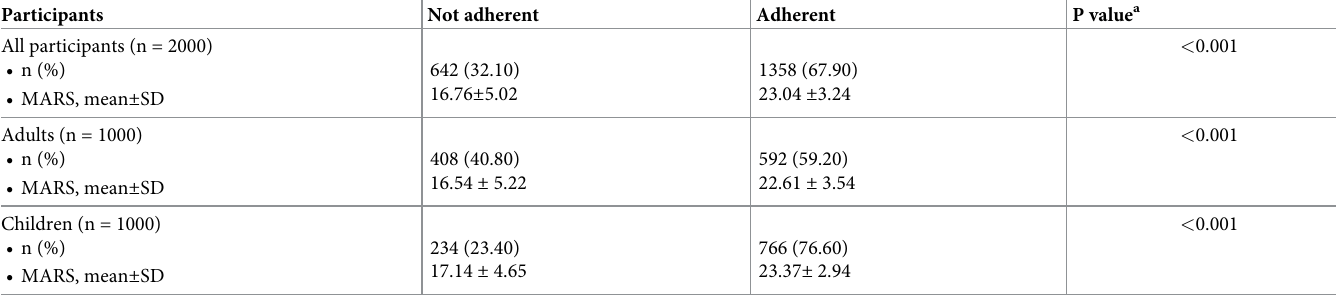
Table 2. Non-adherence of participants to short-term antibiotics.